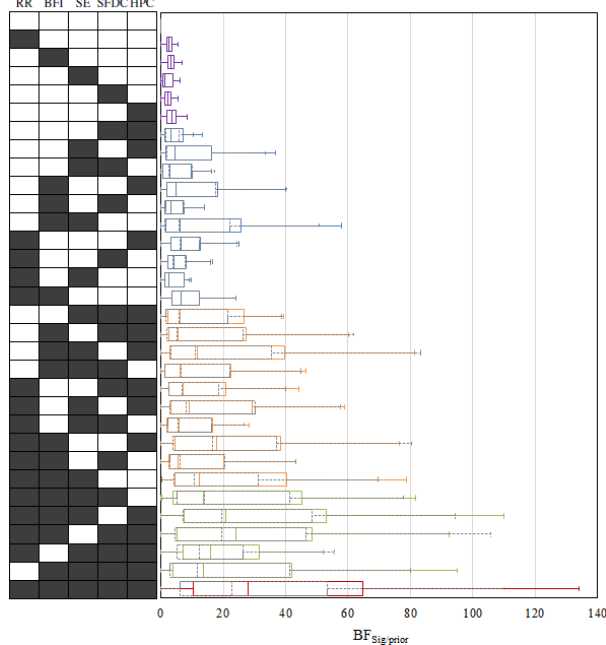
Figure 3. Boxplots representing the distribution of the Bayes factor for each combination of signatures for synthetic streamflow data. The colored boxplots correspond to the results obtained when inter- signature error correlations are considered in the likelihood func- tion, whereas the grey dashed boxplots correspond to the results obtained assuming that the inter-signature errors are